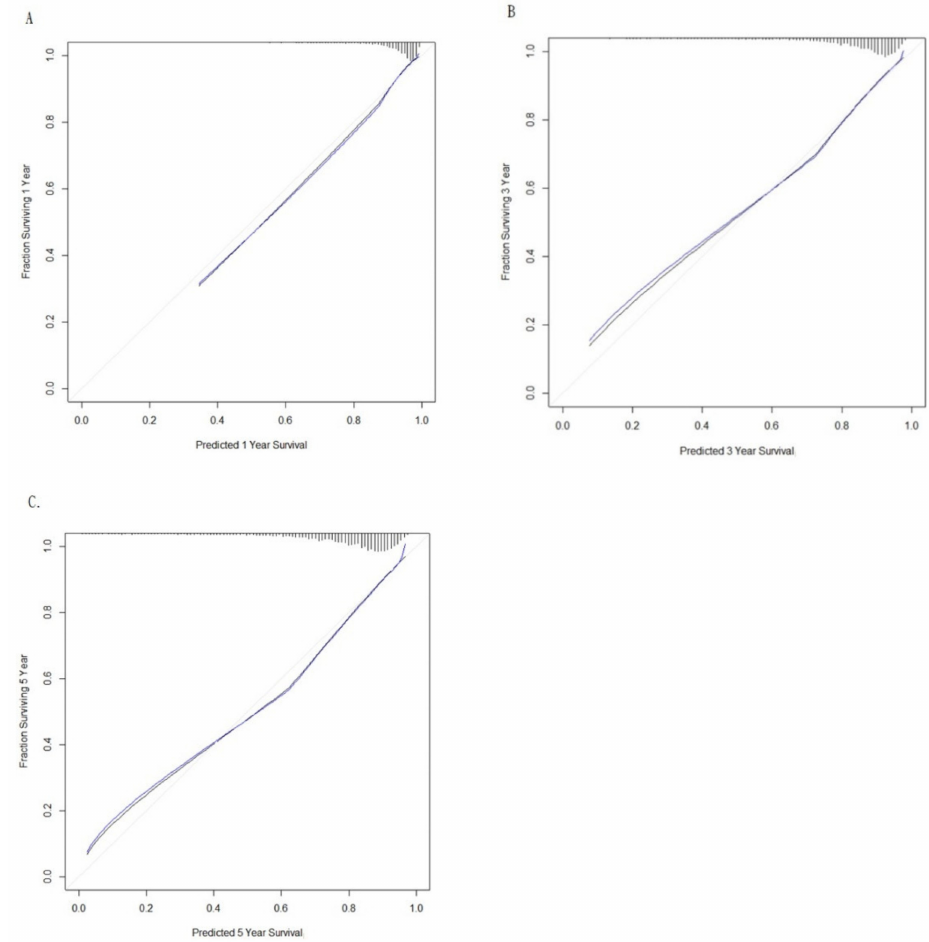
Figure 5. Kidney cancer overall survival nomogram calibration plots: ( A ) 1-year, ( B ) 3-year and ( C ) 5-year nomogram calibration curve. Y axis represents observed probability. X axis represents predicted probability. The predicted and observed probabilities of survival are graphed on the horizontal and vertical axes, respectively. The grey line indicates the reference line, on which an ideal model would lie. The black line represents observed, and blue line represents optimism-corrected,